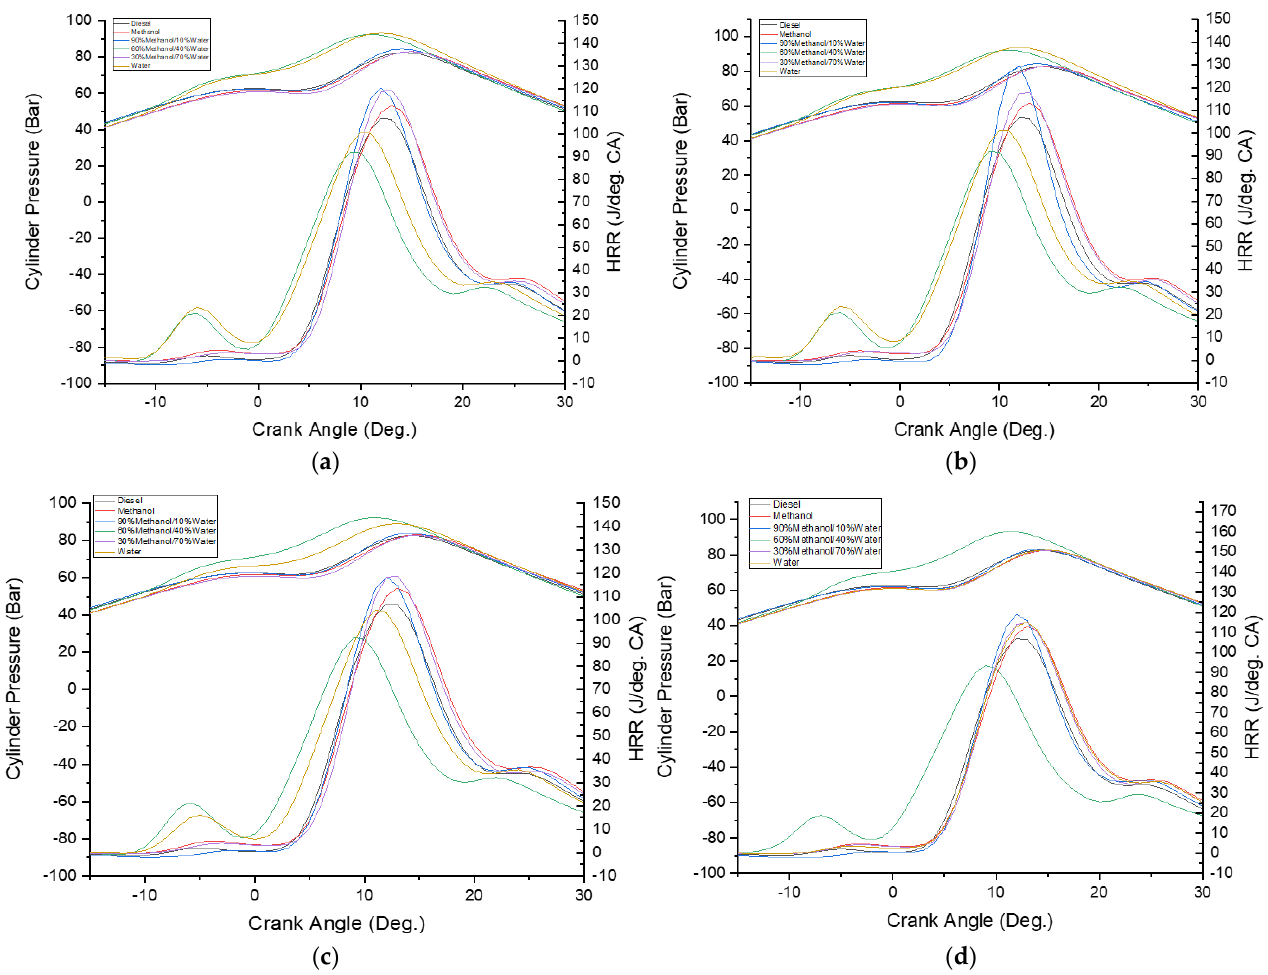
Figure 6. Changes in cylinder pressure and heat release rate under different fuel mixture ratios and substitution rates (( a ) substitution rate is 10%, ( b ) substitution rate is 20%, ( c ) substitution rate is 30%, ( d ) substitution rate is 40%).